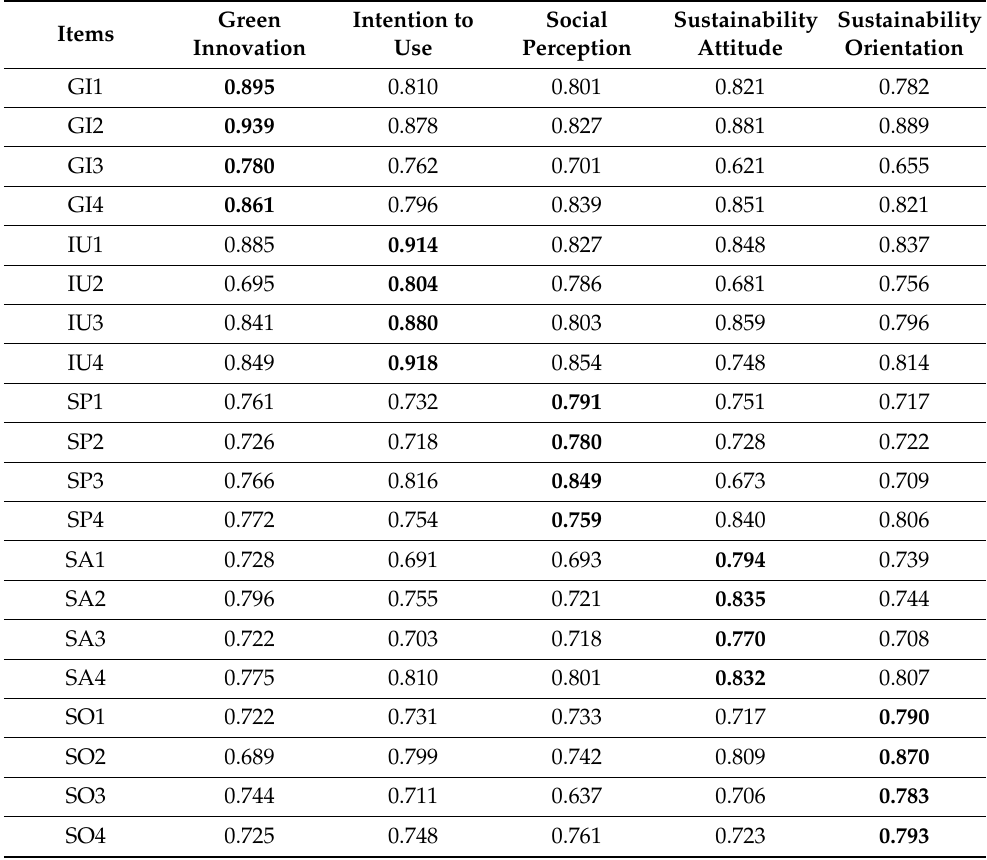
Table 6. Values of the cross loads of individual items in the SEM.